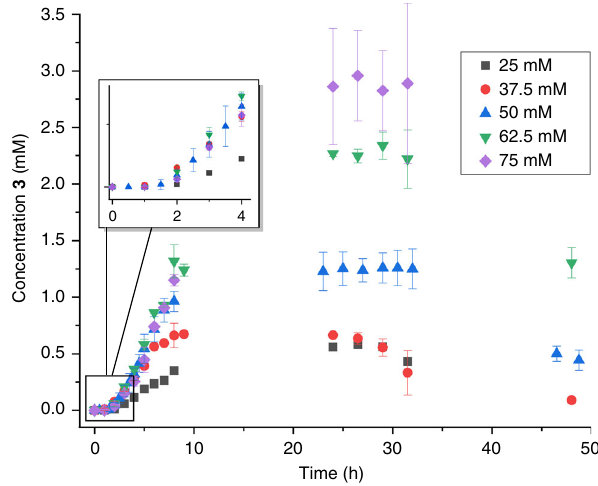
Fig. 4 Effect of the initial concentration of 1 on the assembler concentration. Increasing the initial concentration of compound 1 results in faster formation of 3 , whereas the destruction rate is unchanged, increasing the concentration of 3 throughout the experiment. All experiments show an initial period of autocatalytic growth (see insert), followed by a period of constant [ 3 ] and fi nally destruction of the assembler. Concentrations were determined using UPLC, whereas error bars represent the standard deviation. Source data are provided as a Source Data fi